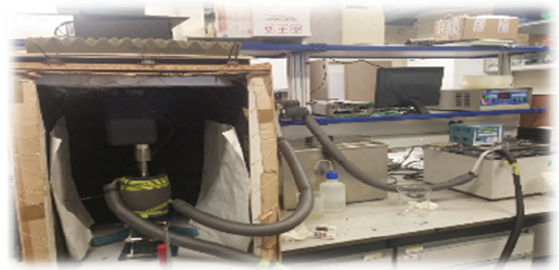
Figure 1. Experimental set ‐ up for ultrasound assisted extraction.